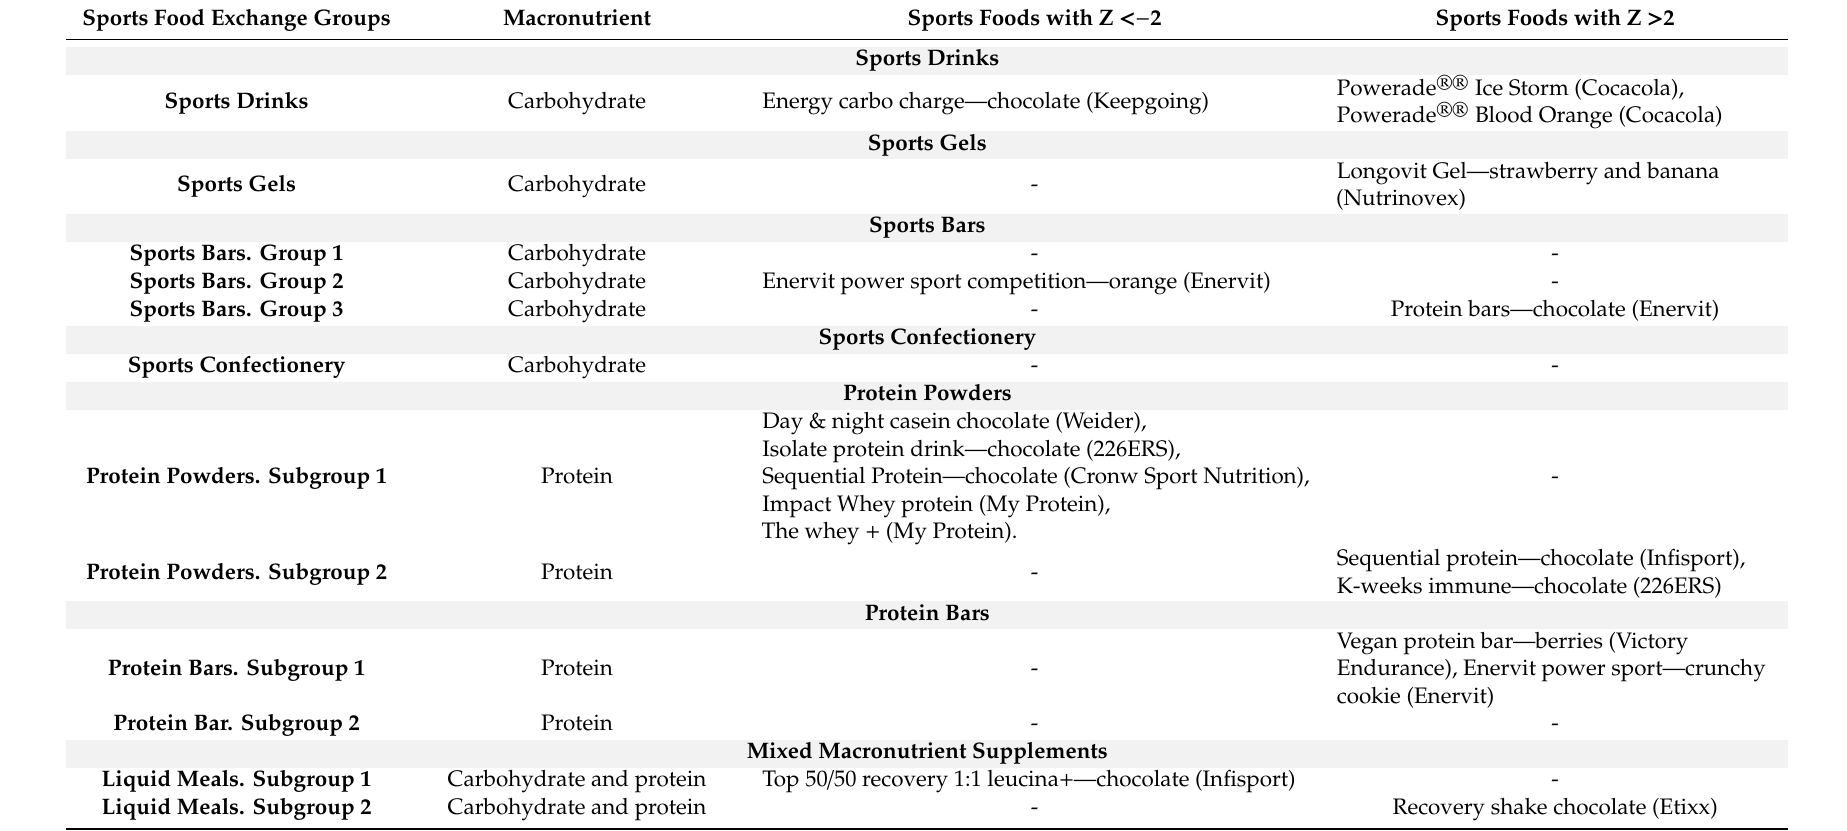
Table 4. Foods with Z values outside the limits ( ± 2) for the main macronutrients of the sports foods